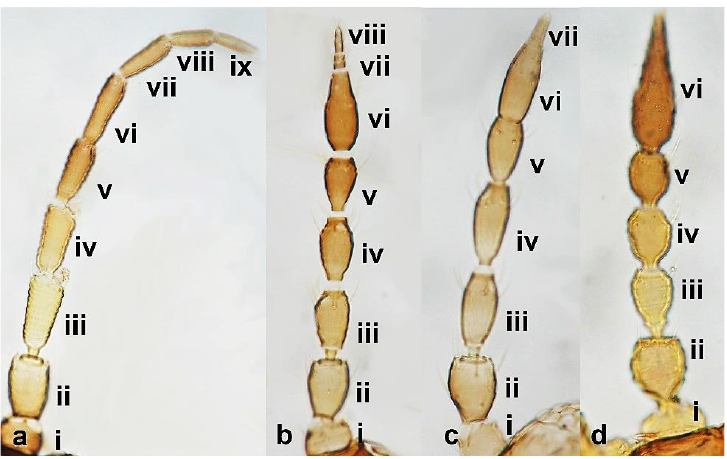
Figure 16. Antenna ( a – d ): ( a ) nine-segmented; ( b ) eight-segmented; ( c ) seven-segmented; ( d ) six- segmented.